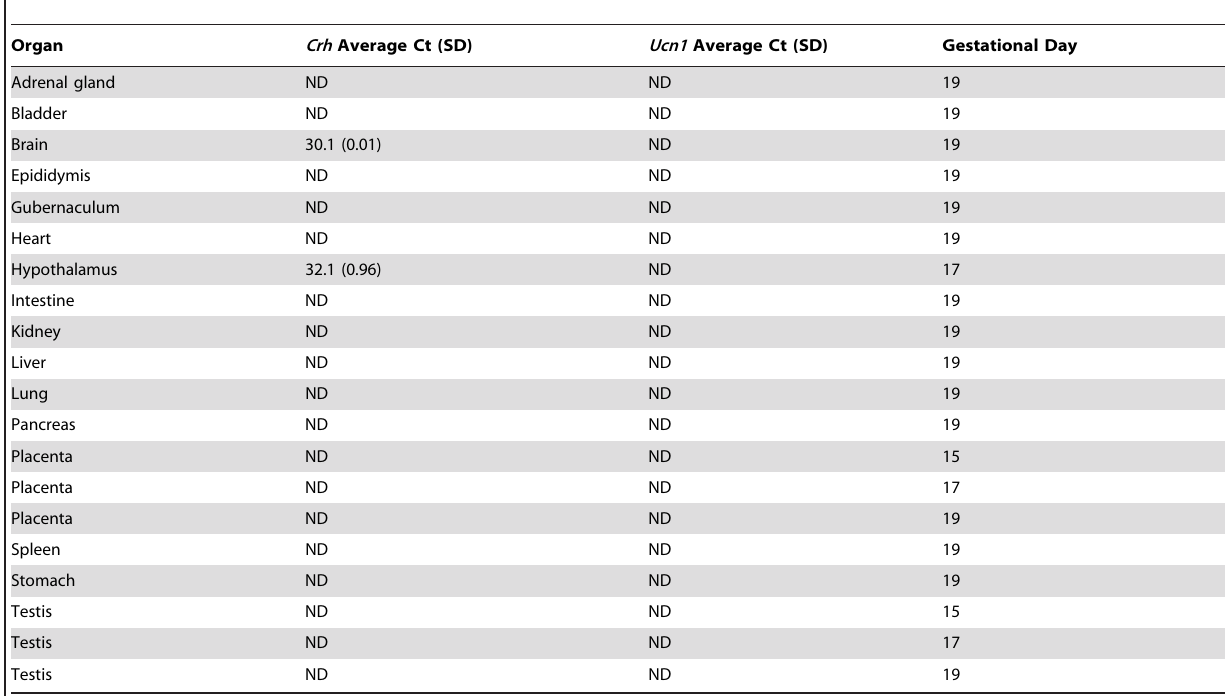
Table 3. Cycle threshold (Ct) values of Crh and Ucn1 mRNA in rat fetal tissues.